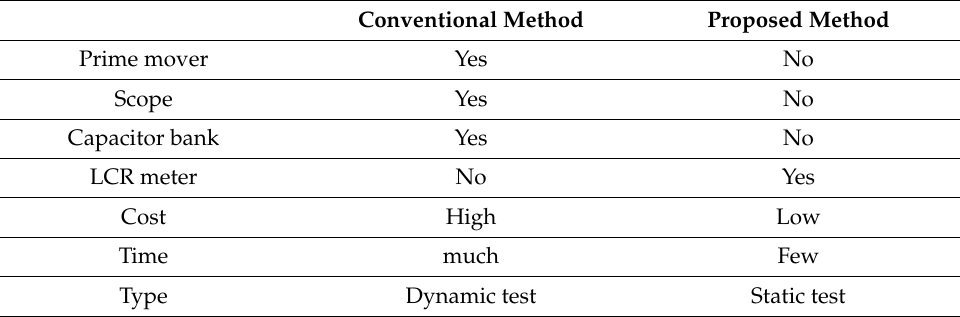
Figure 11. ( a ) the conventional and ( b ) the proposed method to identify phase sequence in five-phase combined star–pentagon machine. Table 4. Comparison between the proposed and the conventional method of identification of phase sequence.